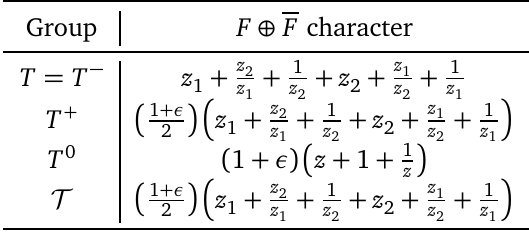
Table 6: Character for the F ⊕ F representation of (cid:221) SU ( 3 ) for various fugacity sub-